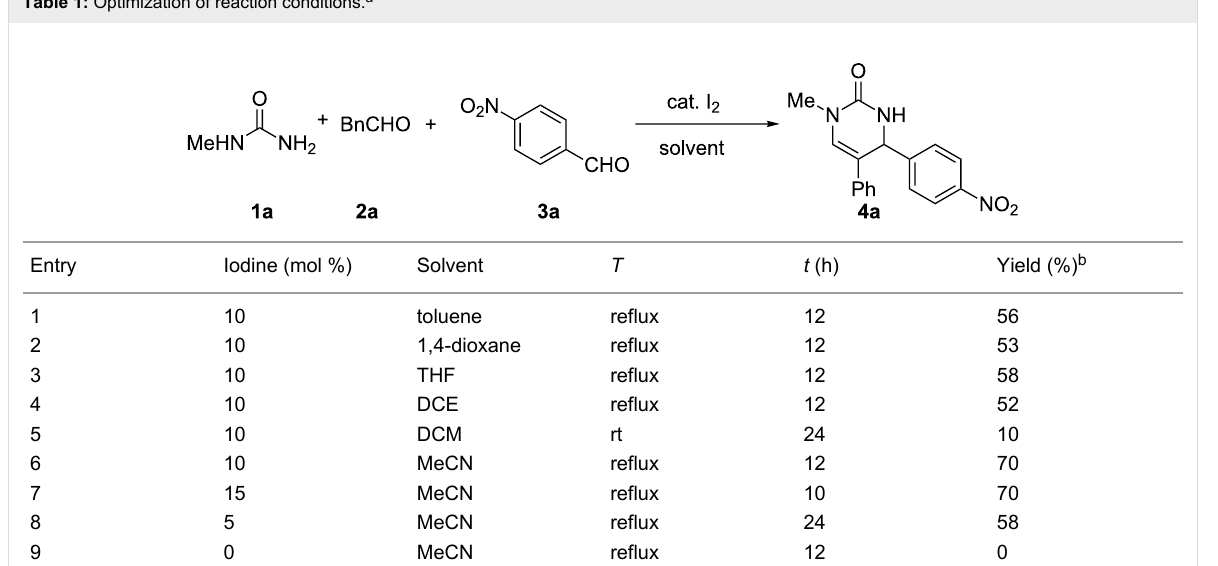
Table 1: Optimization of reaction conditions. a